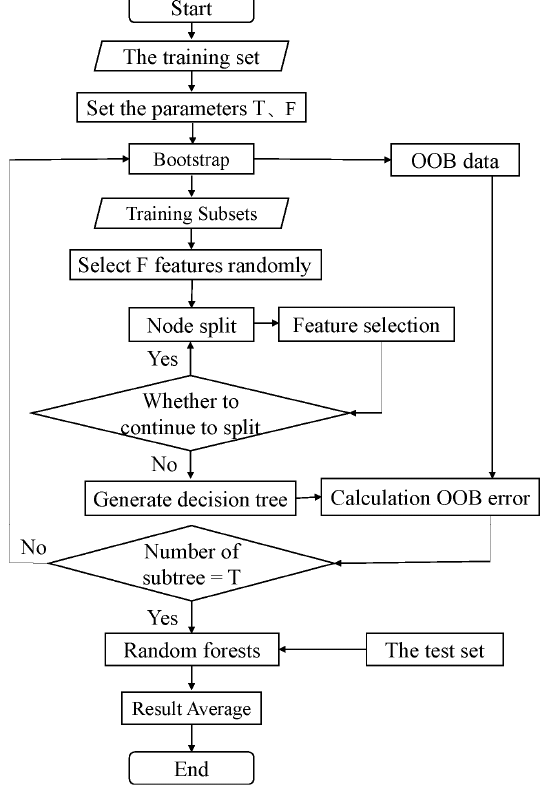
Figure 2 . Flow chart of the algorithm for the random forest. Figure 2. Flow chart of the algorithm for the random